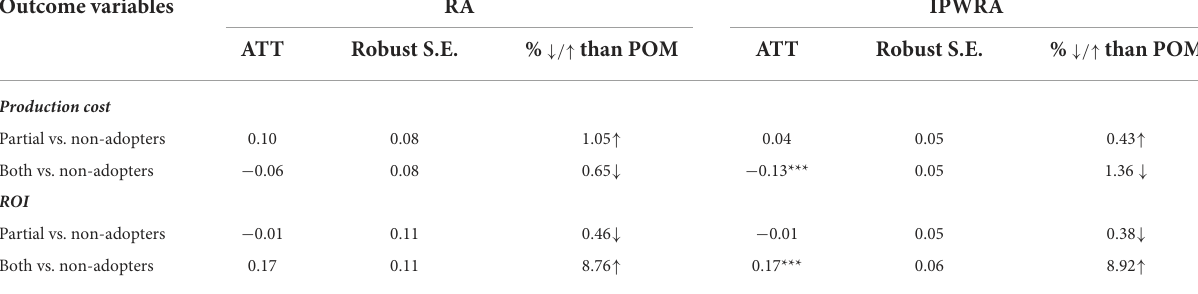
TABLE 5 Average treatment effects of SIRFD adoption on outcome variables. Outcome variables RA IPWRA ATT Robust S.E. % ↓ / ↑ than POM ATT Robust